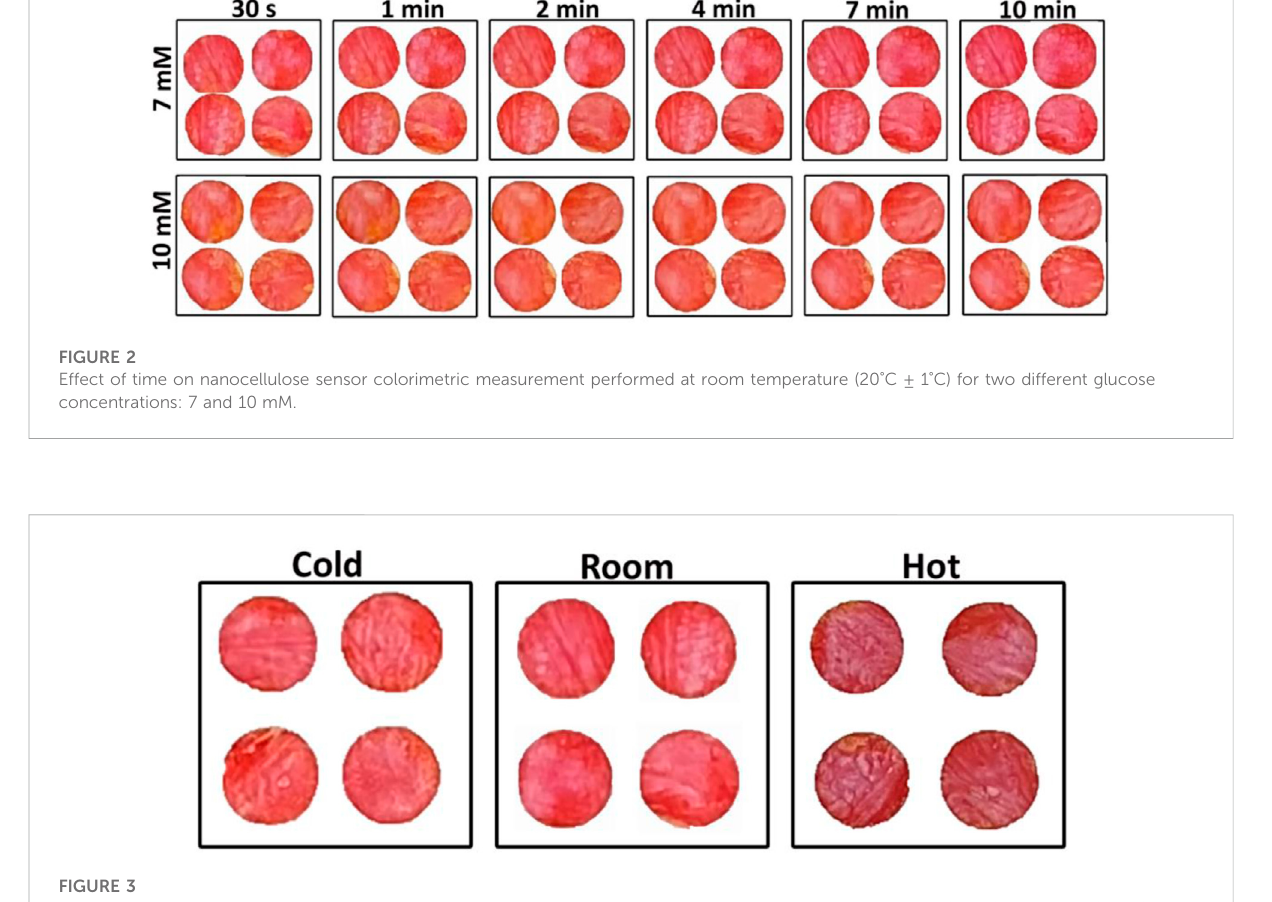
Frontiers in Bioengineering and